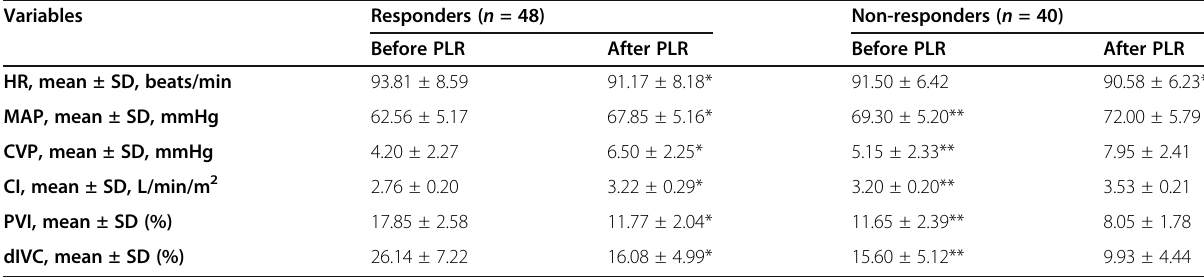
Table 2 Hemodynamic variables before and after passive leg raising